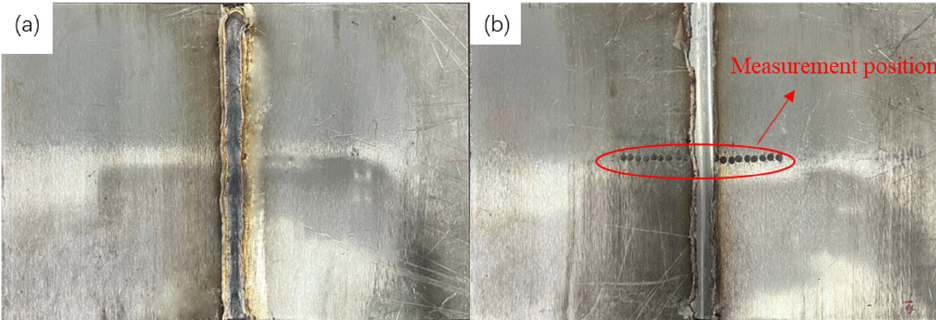
Figure 2. 316L stainless steel plate sample: ( a ) Before cutting weld reinforcement; ( b ) After cutting weld reinforcement.